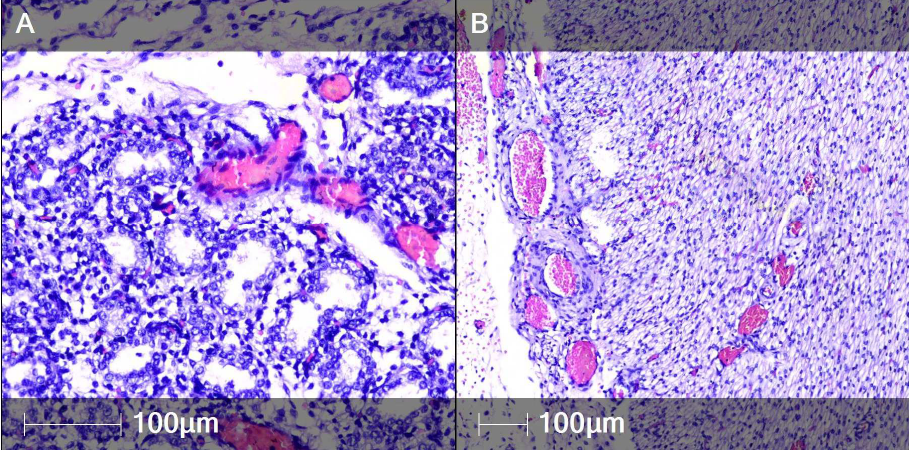
Figure 6. Vascular anomalies in fetal tissue (H&E staining). Vascular congestion with erythrocyte aggregation (pink staining) in fetal organs. ( A ) Lung; ( B ) Myocardium.